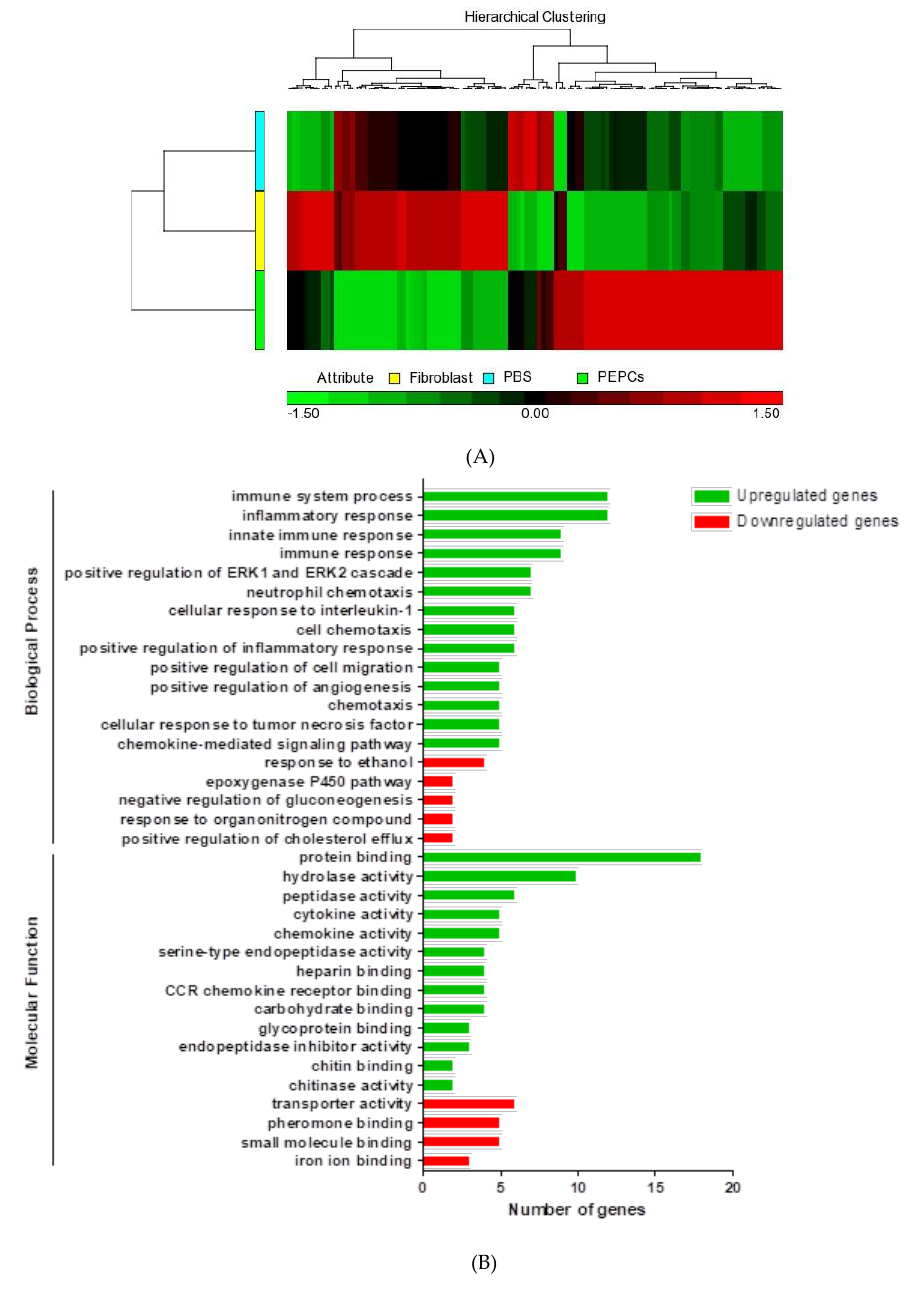
Figure 5. The di ff erence of microarray gene expression profile after PEPCs-injected ischemic heart. ( A ) Hierarchical clustering heatmap displaying genes that were upregulated (red) or downregulated (green) in response to PEPCs, fibroblasts or PBS exposure ( > 1.5-fold change). ( B ) Gene ontology enrichment analysis of 95 di ff erentially expressed genes revealed the enriched biological process and molecular function. Representative gene ontology terms listed on the bar plot have enrichment p values < 0.05 and the horizontal axis was the gene